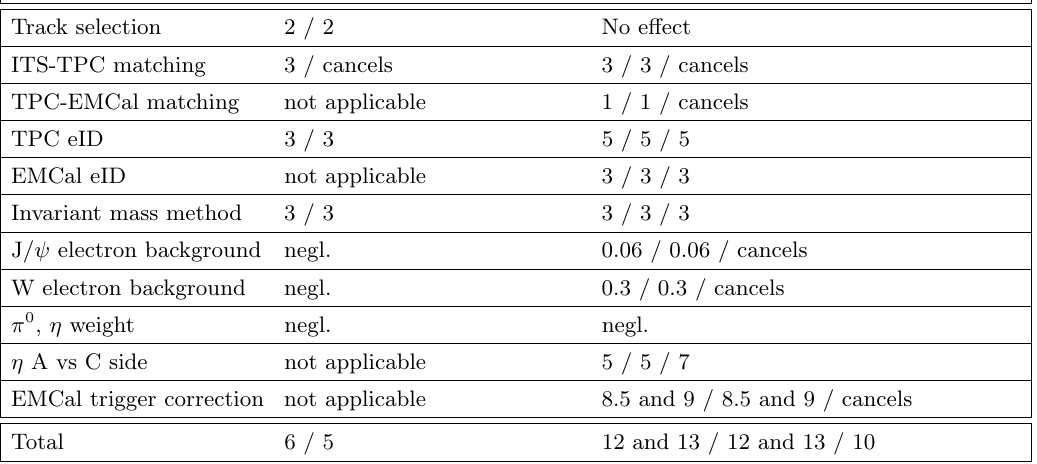
Table 3 . Systematic uncertainties for the TPC only and TPC+EMCal analysis in percentual values. yield int and yield cent represent the invariant yield for integrated centrality and for di(cid:11)erent centrality classes, respectively. For the EMCal trigger correction, the two values presented are for E cluster > 11 GeV and E cluster > 7 GeV, EMC EMC